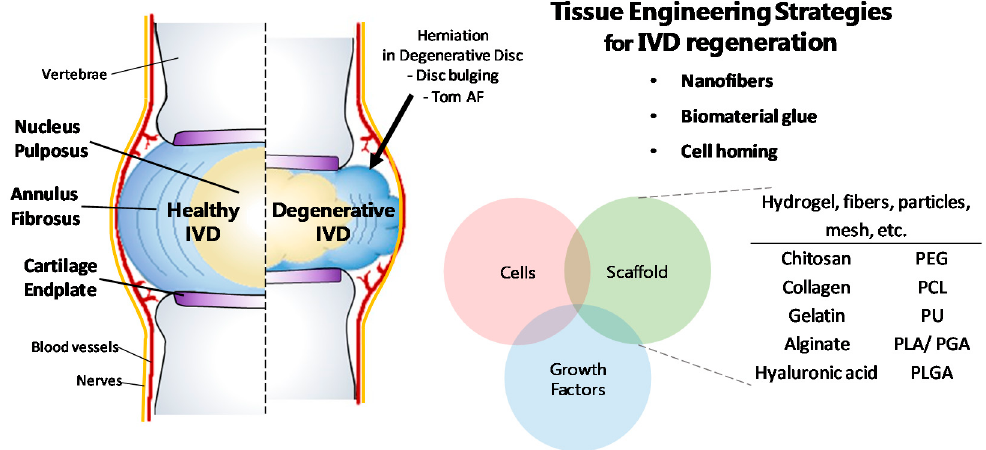
Figure 1. Features of human intervertebral disc (IVD) structure, and regeneration strategies for degenerative IVD using functional polymers in tissue engineering. Polymers are used as scaffolds in various forms such as hydrogel, fibers, particles, and mesh. Abbreviations: AF, annulus fibrosus; IVD, intervertebral disc; PCL, poly- ε -caprolactone; PEG, polyethylene glycol; PGA, polyglycolic acid; PLA, polylactic acid; PLGA, poly (lactic- co -glycolic acid); PU, polyurethane.